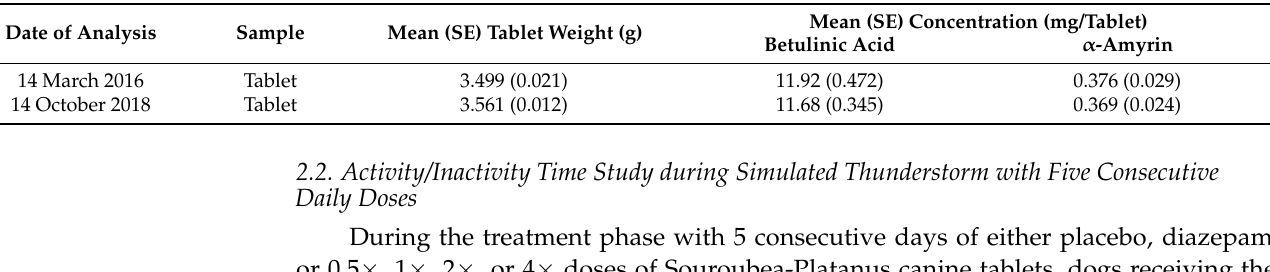
Table 1. Stability of tablets as measured by changes of active